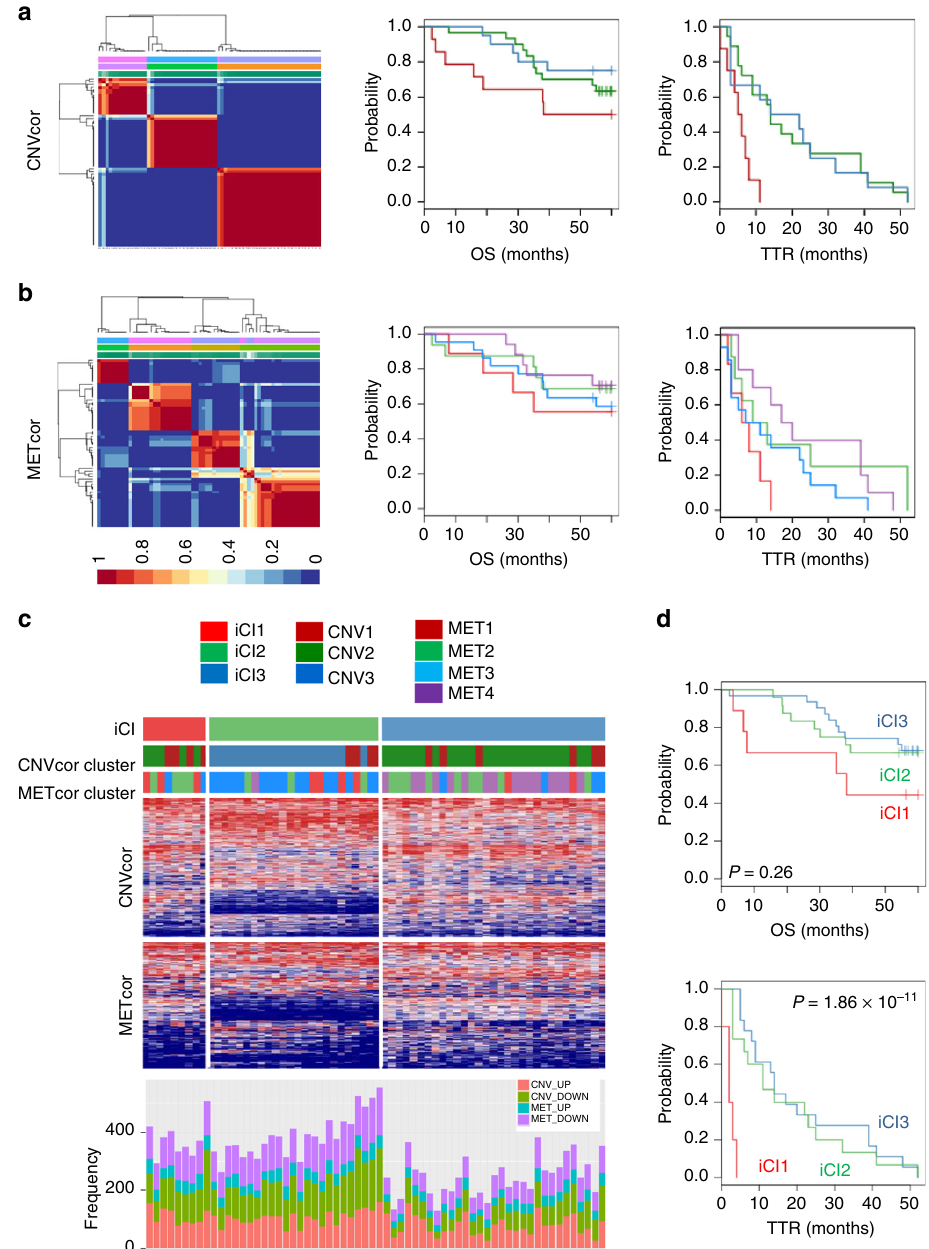
Fig. 2 Identi fi cation of molecular subtypes of HCC using CNVcor and METcor genes. a , b Plots show the non-negative factorization (NMF) cluster results for the CNVcor in CNV data ( a ) and for the METcor in MET data ( b ), respectively. Kaplan – Meier plot analyses for subtypes identi fi ed by NMF clustering of the CNVcor and METcor genes are shown for overall survival (OS) and time to tumor recurrence (TTR), respectively. c Heatmaps show the expression patterns of subtypes identi fi ed by iCluster analysis. The subtypes identi fi ed by the CNVcor or METcor genes using NMF cluster methods are indicated with colored bars (top). The frequencies of aberrant expression of CNVcor_UP, CNVcor_DOWN, METcor_UP, and METcor_DOWN genes in each subtype are shown (bottom). d Kaplan – Meier plot analyses for subtypes identi fi ed by iCluster (iCl1, iCl2, and iCl3) are shown for overall survival (OS) and time to tumor recurrence (TTR),